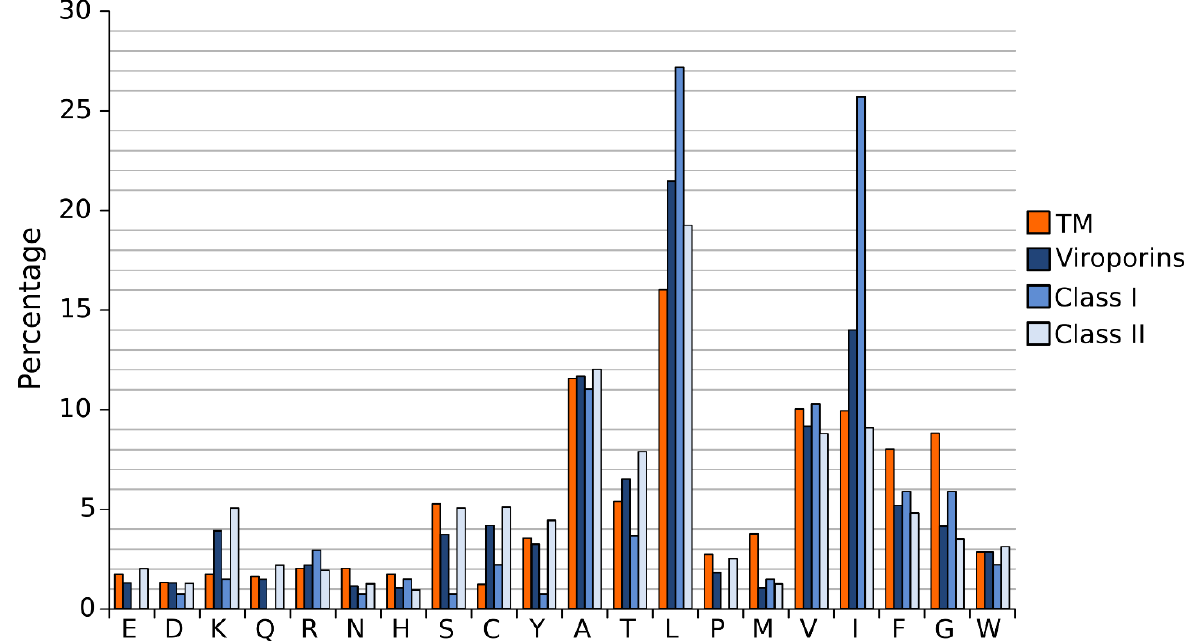
Figure 4. Amino acid distribution in viroporin TM segments. Amino acid distribution from 792 TM helices from a set of non-redundant proteins of known structure (orange) and viroporin putative TM regions (blue) (data from viroporins shown in Figures 1 and 2). Viroporin hydrophobic regions were analyzed jointly (darkest blue) and separately by class (lighter blues).